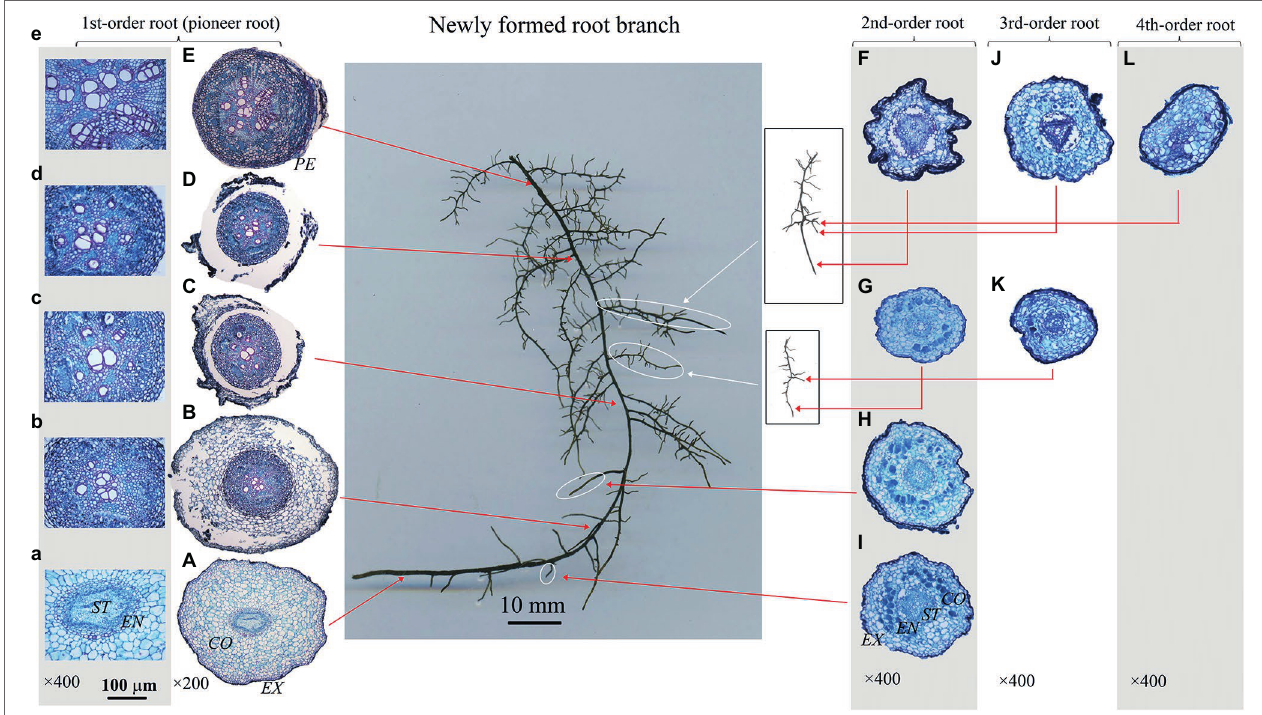
FIGURE 2 | Protoxylem group (PG) arrangement along root developmental order of Juglans mandshurica under control. There were five PGs (A,B) in first-order root, four PGs (F–I) in second-order roots, three (J) and two (K) PGs in third-order roots, and two (L) PGs in fourth-order root, respectively. The nature of PG in first-order root was obvious in primary growth (A,B) , but lost in the secondary growth (C–E) . EX , exodermis; CO , cortex; EN, endodermis; ST , stele; PE , periderm.